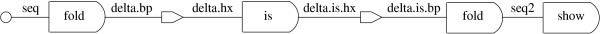
A typical pipeline of simulation, selection, reconstruction, and visualization.